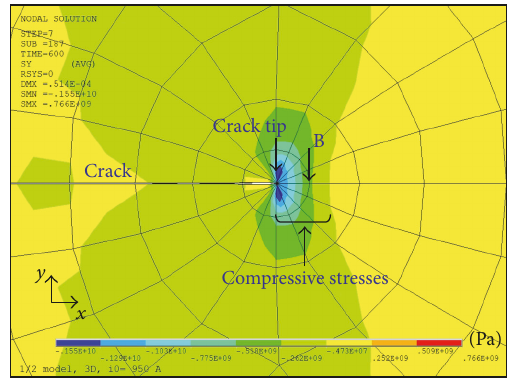
Figure 11: Contour of stress 𝜎 𝑦 near crack tip ( 𝑡 = 600 s).